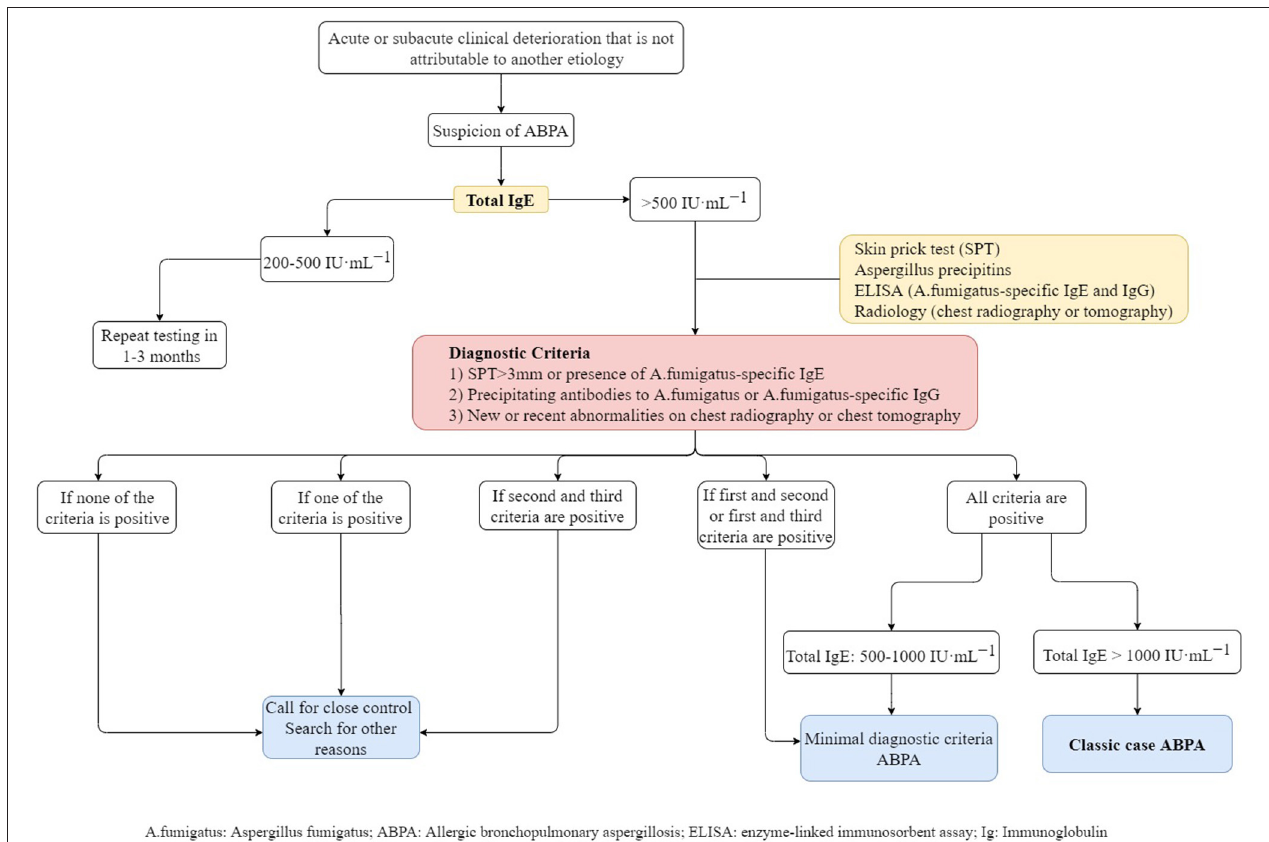
FIGURE 1 | Diagnostic algorithm of ABPA in